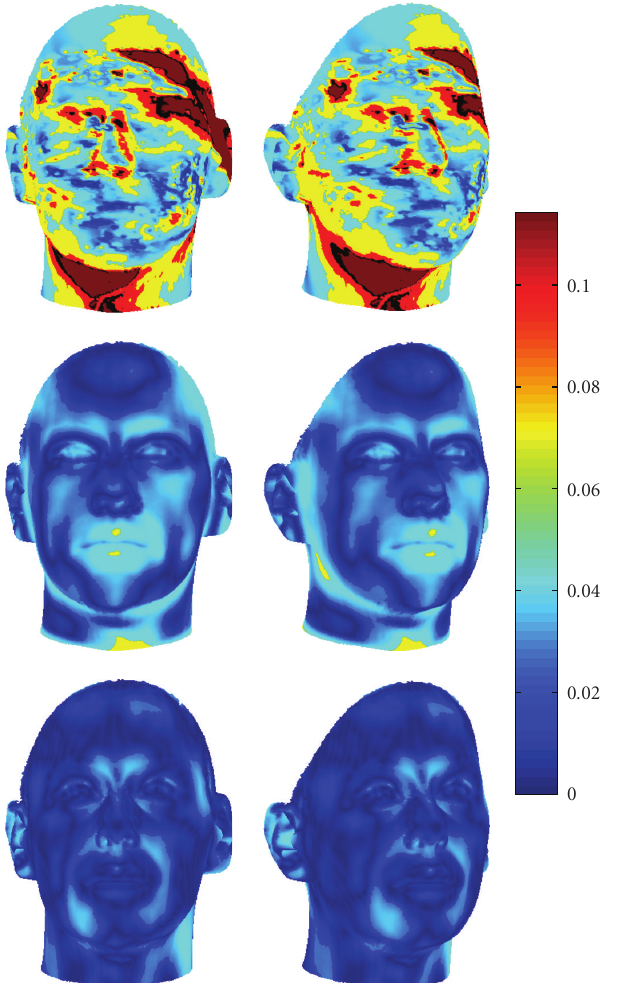
Figure 5: The distances of the correspondent points are visualized as colors on the source 3D face. The color of each point represents the distance from the point to its correspondent point with the color-mapping on the right. The top two are the results of the optical flow method. The middle two are the results of the ICP algorithm with rigid transformation. The bottom two are the results of the TPS method.